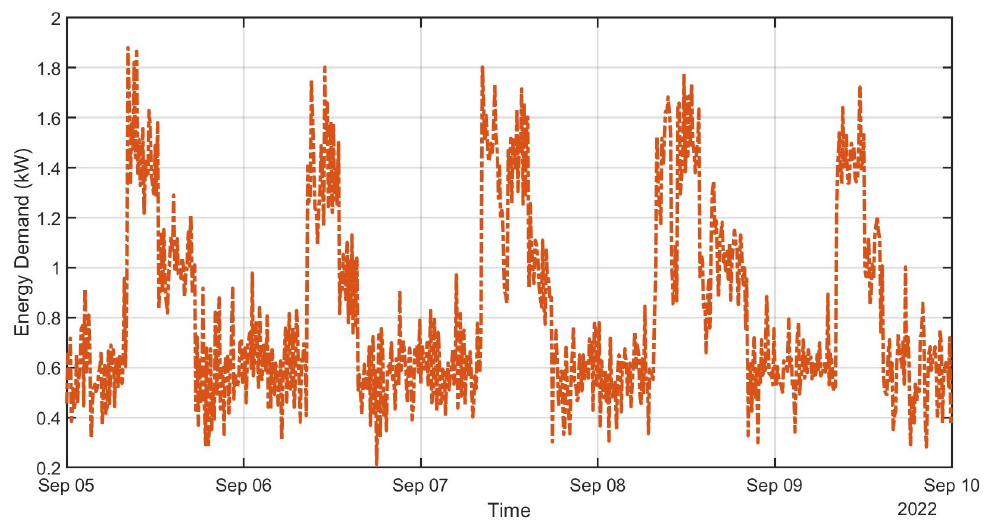
Figure 4. Representation of energy demand for five